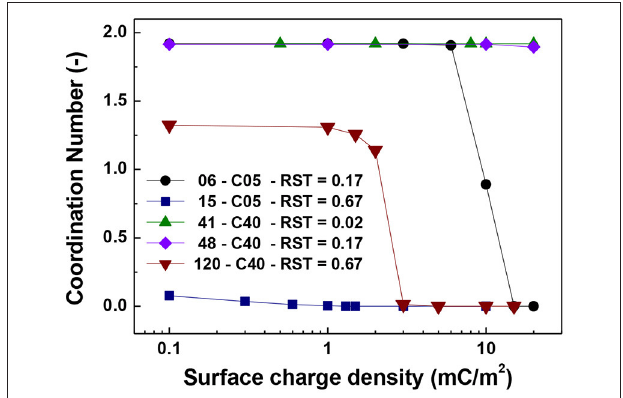
FIGURE 7 | Largest fragment ratio vs. surface charge density. The figure presents the comparison for cases of shell thickness equal to 50nm (06-C05 and 41-C40) and two values of relative shell thickness of 0.17 (06-C05, 48-C40) and 0.67 (15-C05 and 120-C40).